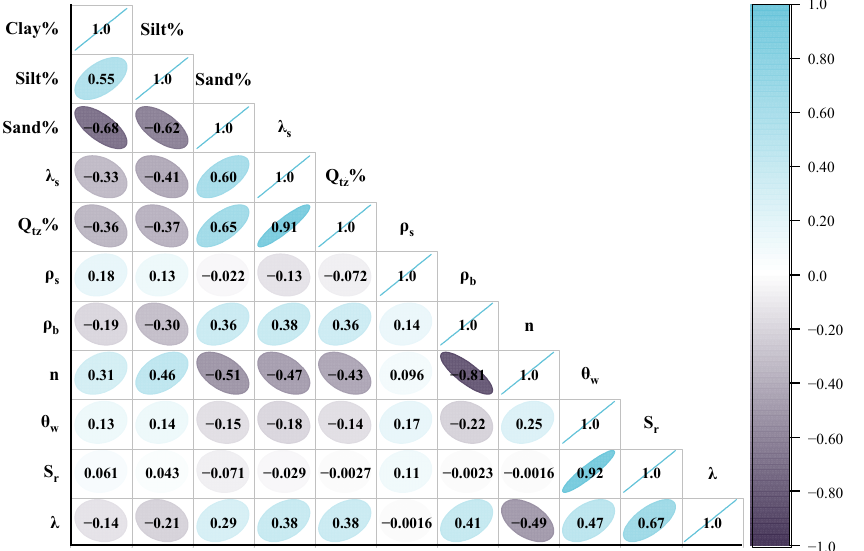
Figure 1. Correlation characteristics of 10 parameters and thermal conductivity ( λ ) in the dataset.